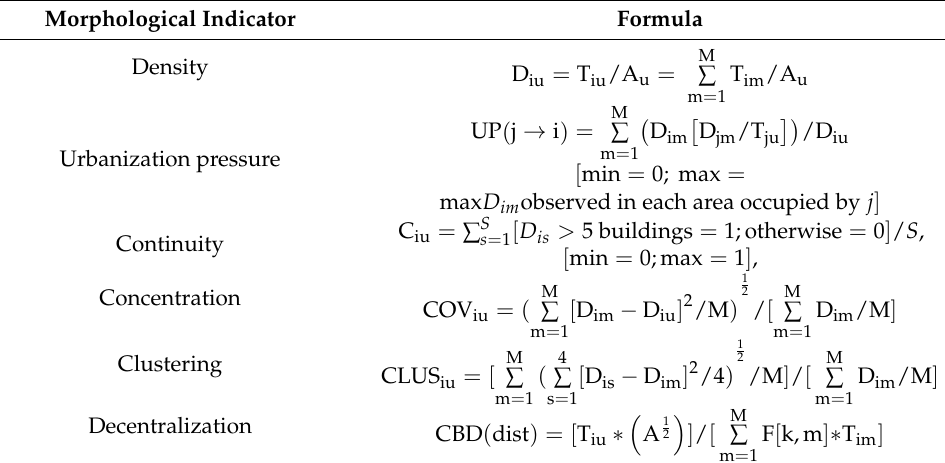
Table 1. Procedure of GIS analyzes performed in the second step. Description Program Preparation of a squares grids of 1 km and 500 m sides for each grid for the whole country; squares grids were superimposed in such a way that each grid of 1 km 2 contained 4 grids with a side of 500 m. Loading the layer with the location of buildings from the CCGCD database. SpatiaLite Analysis of the number of buildings in square grids. SpatiaLite Aggregation of layers to be deducted under DL. QGIS Intersection of DL layers with a square grid taking into account the number of buildings. Joining the square grid layers with the DL area and calculating the DL area. SpatiaLite Connecting the aggregate layer of buildings with individual communes and urban areas. Converting the polygon layer of buildings to point layer, resulting in working layers